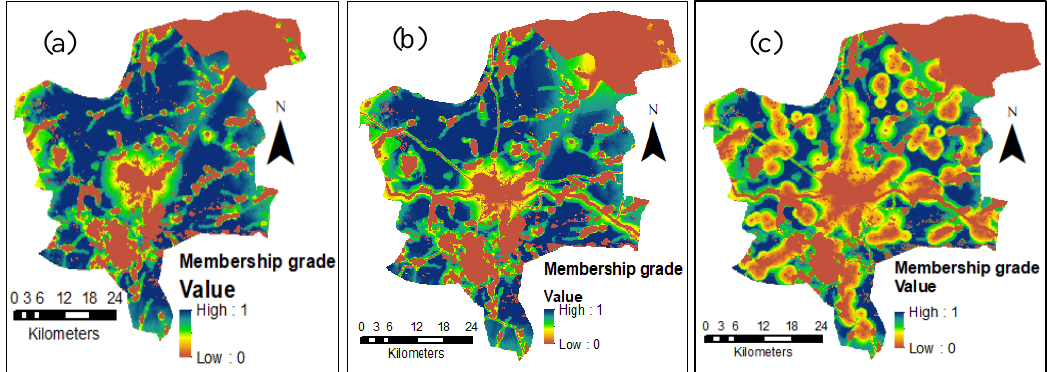
Figure 8. Comparison of landfill suitability maps ( a ) results without including OpenStreetMap (OSM) and open government data (OGD) data ( b ) results including OSM ( c ) results including both OSM and OGD for scenario 6 where α = 0.9.